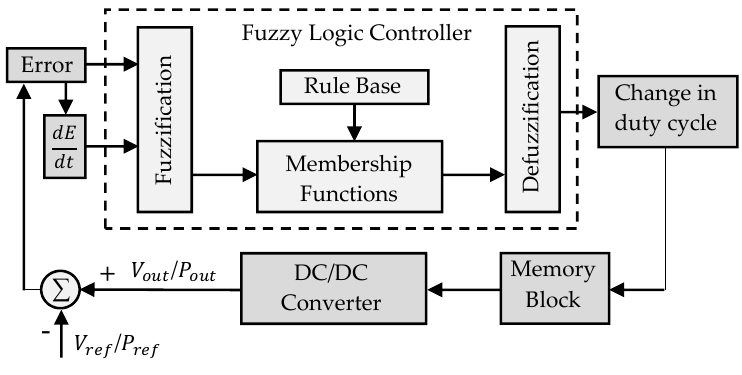
Figure 4. Fuzzy Logic Control Structure .